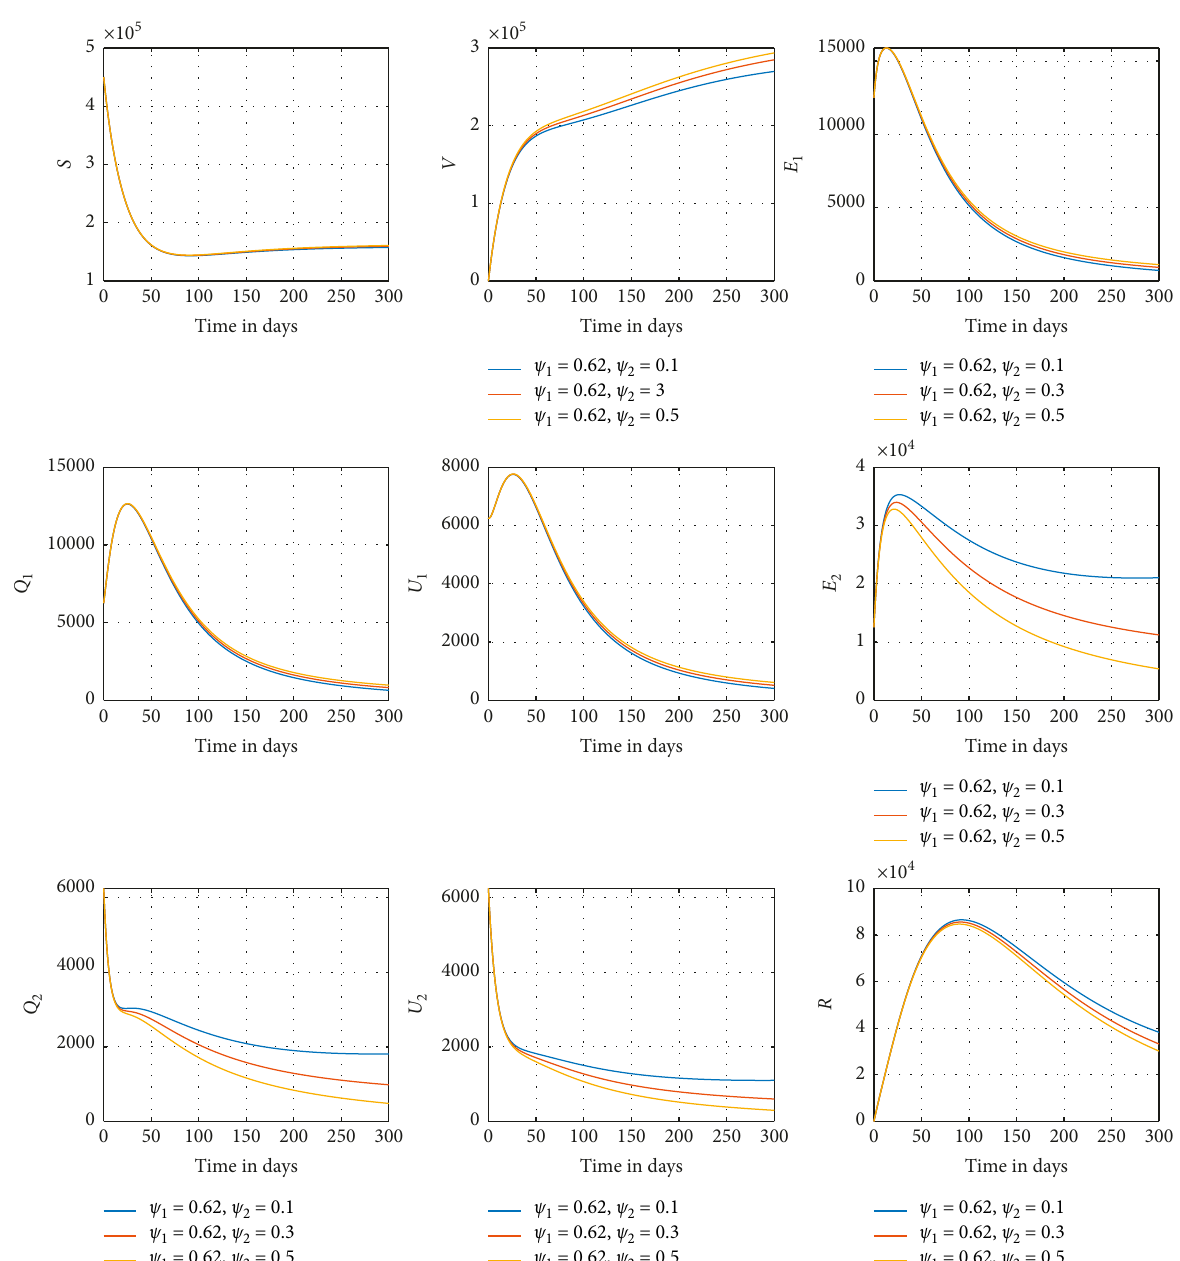
Figure 5: These graphs are obtained by numerically solving the model using ψ � 0 . 62 and other parameter values as contained in Table 1. 1 � 0 . 8287, where S is the susceptible individuals, V is the vaccinated individuals, E is the With this choice of parameter values, R SV 1 c individuals exposed to variant 1, Q is the quarantined individuals who are infected with variant 1, U is the undetected individuals who are 1 1 is the individuals exposed to variant 2, Q is the quarantined individuals who are infected with variant 2, U is the infected with variant 1, E 2 2 1 undetected individuals who are infected with variant 2, and R is the recovered